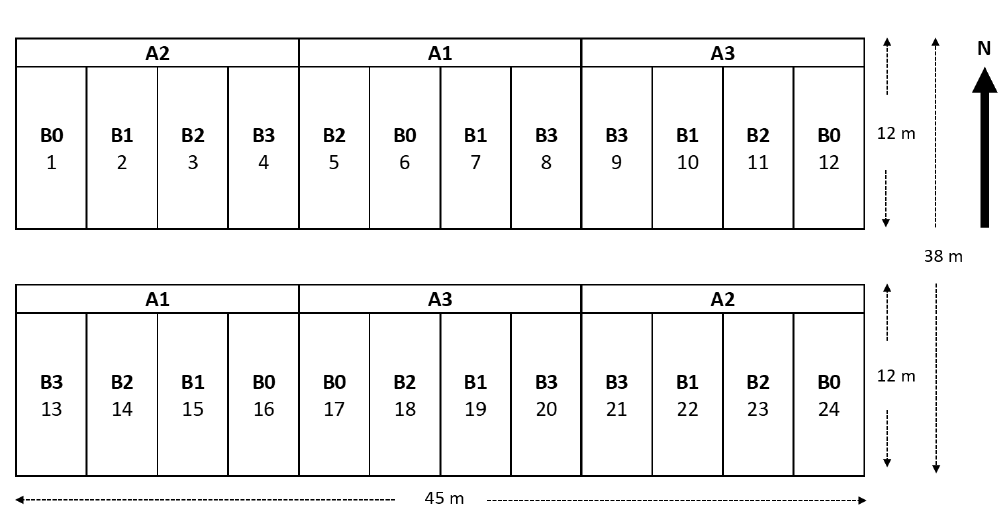
Fig. 1. Experimental split-plot design with factors timing (A) and traffic intensity (B)